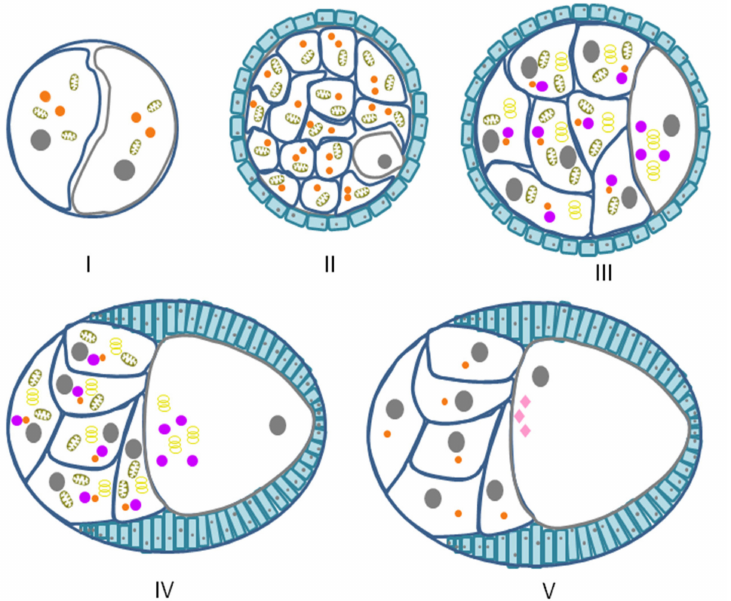
Figure 2. Schematic diagram of various stages of Drosophila oogenesis. ( I ). Schematic drawing of the germarium. ( II ). Stage 2, the daughter cell divides incompletely to produce a cyst of 16 cells. One of the 16 cells becomes an oocyte (grey outline), and the other 15 differentiate into nurse cells (blue outline). ( III ). Stages 6–8, the maturing cyst moves down the germarium getting surrounded by somatic follicle cells (blue fill), which intercalate and pinch it off to form a discrete egg chamber. The first polarization of the oocyte is shown. ( IV ). Stage 9. ( V ). Stage 10, stem cells are outlined with grey, daughter cells are outlined with blue, follicular cells are outlined with jade green, and nuclei are shown as closed grey circles. Sponge bodies (closed purple circles). Nuage (closed orange circles). Polar granules (closed pink rhombs). Mitochondria (brown ellipse). Golgi (yellow